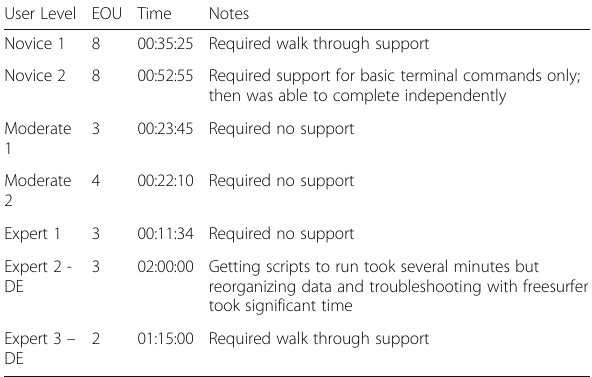
Table 6 (abstract A16). User feedback User Level EOU